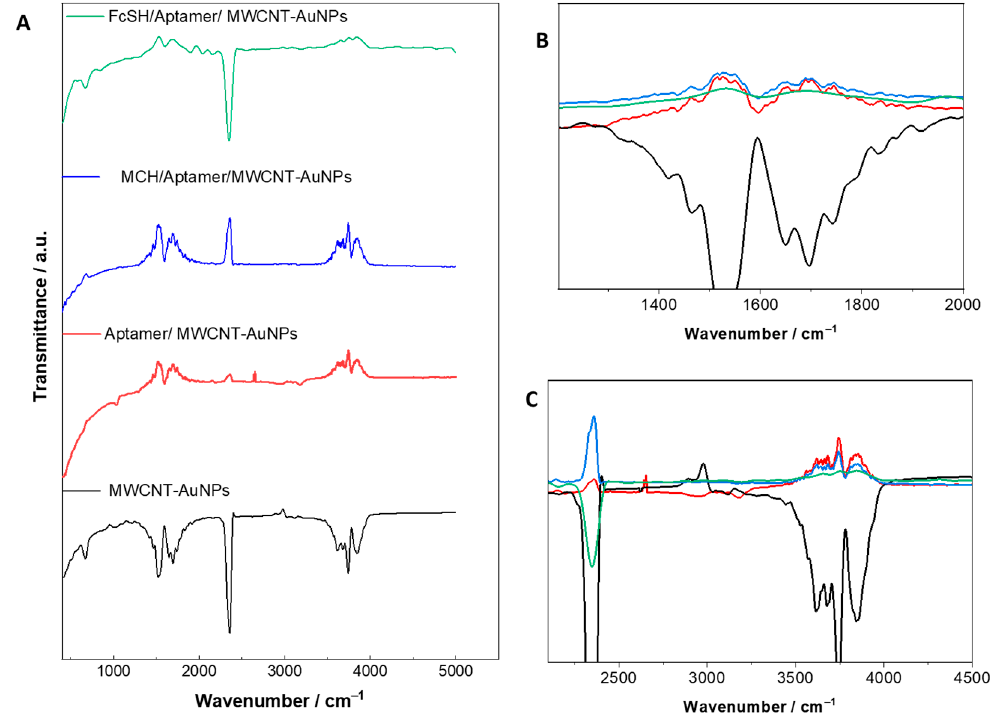
Figure 4. ( A ) FTIR spectra of bare MWCNT/AuNP (black), aptamer/MWCNT/AuNP (red), MCH/aptamer/MWCNT/AuNP (blue) and FcSH/aptamer/MWCNT/AuNPs (green) measured in the spectral range of 900–4800 cm − 1 ; ( B ) shows the magnified plots of the bands from 1200 to 2100 cm − 1 and ( C ) 3350 to 4150 cm − 1 .